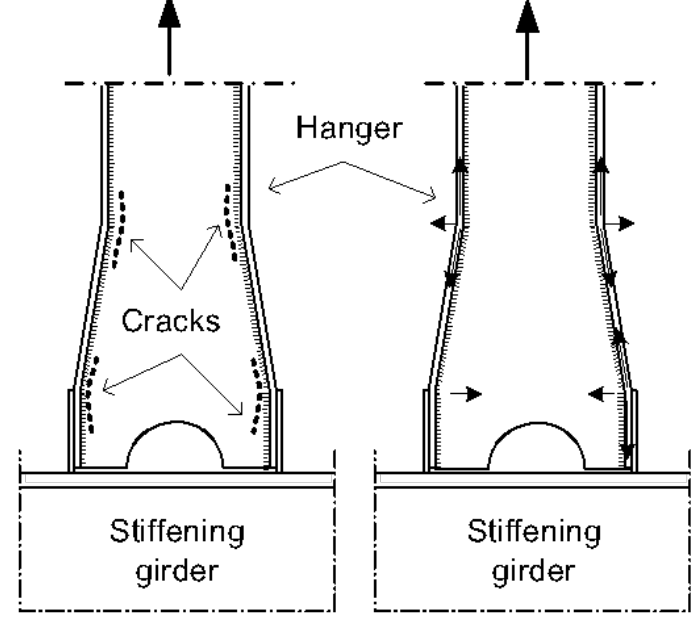
Figure 6. Fatigue cracking in a vertical hanger with a change in cross-section near its connection to the stiffening girder in an arch